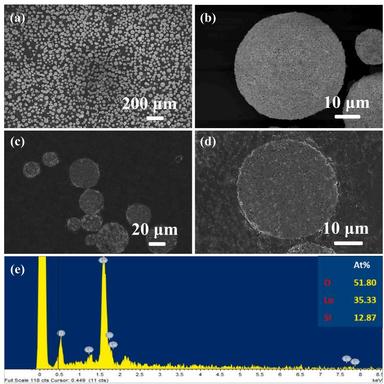
SEM images of X2-Lu2SiO5 feedstocks (a-b) surface topography, (c-d) section morphology and (e) EDS.